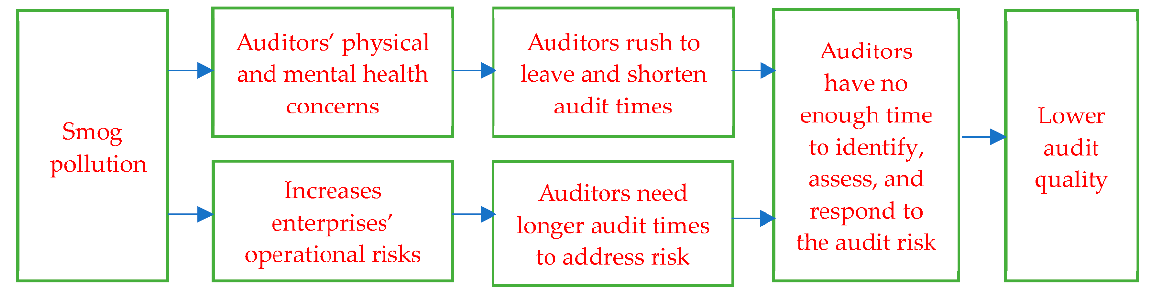
Figure 1. Mechanism of smog pollution affecting audit quality.